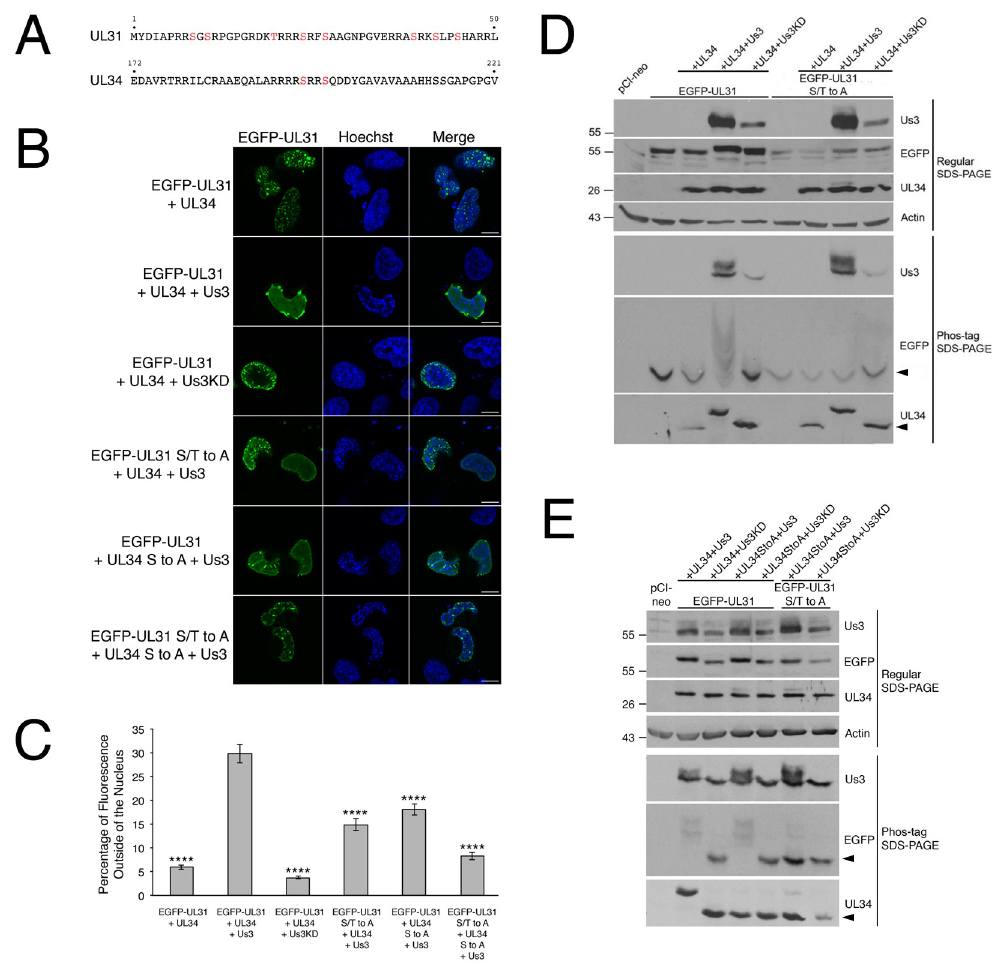
Fig 4. NEC distribution and phosphorylation in transfected HeLa cells. (A) Potential pUs3 substrates, indicated in red, reside in HSV-2 pUL31 (top) and in HSV-2 pUL34 (bottom). (B) HeLa cells were co-transfected with the expression plasmids indicated on the left of each panel. At 18 hours post transfection, cells were fixed and nuclei were stained with Hoechst 33342. Representative images of cells with bright fluorescence indicative of robust NEC production are shown. Scale bars are 10 μ m. (C) To quantify the requirements for extravagation formation, HeLa cells were co-transfected with the plasmids indicated on the x-axis, then fixed and stained as described in (B) . Images of 70 to 100 cells were captured for each condition and the percentage of fluorescence outside of the nucleus for each image was determined as described in Materials and Methods. Error bars are standard error of the mean. Asterisks denote significant decreases in the percentage of fluorescence outside of the nucleus in comparison to that of co-transfection with EGFP-pUL31, pUL34 and pUs3, determined by Student’s T test; ���� = P value < 0.0001. (D, E) HeLa cells were transfected or co-transfected with the expression plasmid(s) indicated above each lane. Equal volumes of protein extracts prepared at 18 hours post transfection were electrophoresed through regular or phos-tag SDS polyacrylamide gels and proteins transferred to PVDF membranes. Membranes were probed with antisera indicated on the right of each panel. Molecular weight markers in kDa are indicated on the left side of the panels. Black arrowheads denote the position of unphosphorylated protein